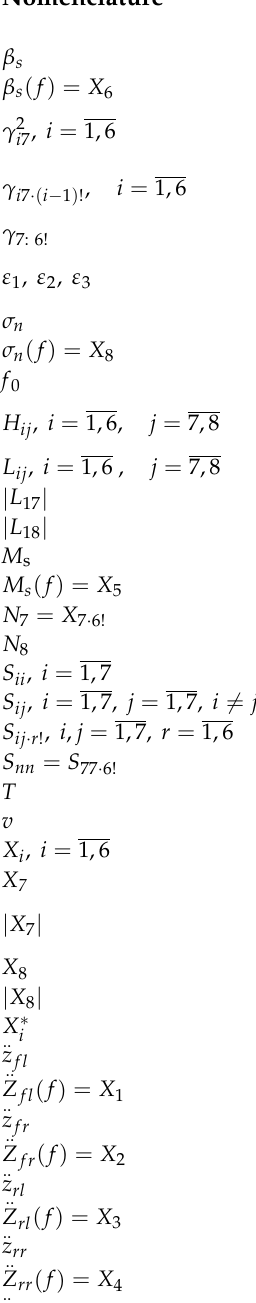
spectrum of vertical acceleration at the center of the rear right wheel .. vertical acceleration at the top of the left shock absorber .. spectrum of vertical acceleration at the top of the front left shock